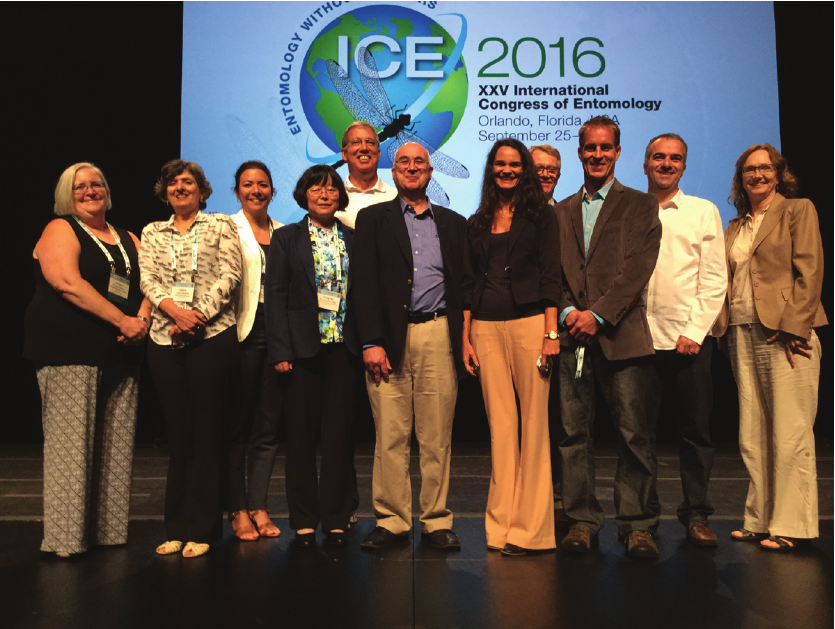
Figure 1. Snapshot of the Zika Symposium at the 2016 International Congress of Entomology in Orlando, FL. From the left: Dr. Adriana Costero; Dr. Celina Martelli; Dr. Duschinka Guedes (back row); Dr. Tang-yan Zhao; Dr. Anthony A. James (back row); Dr. Stephen Higgs; Dr. Constância Ayres; the author (back row); Dr. Brian D. Foy; Dr. Luciano Moreira; and Dr. Fiona F.